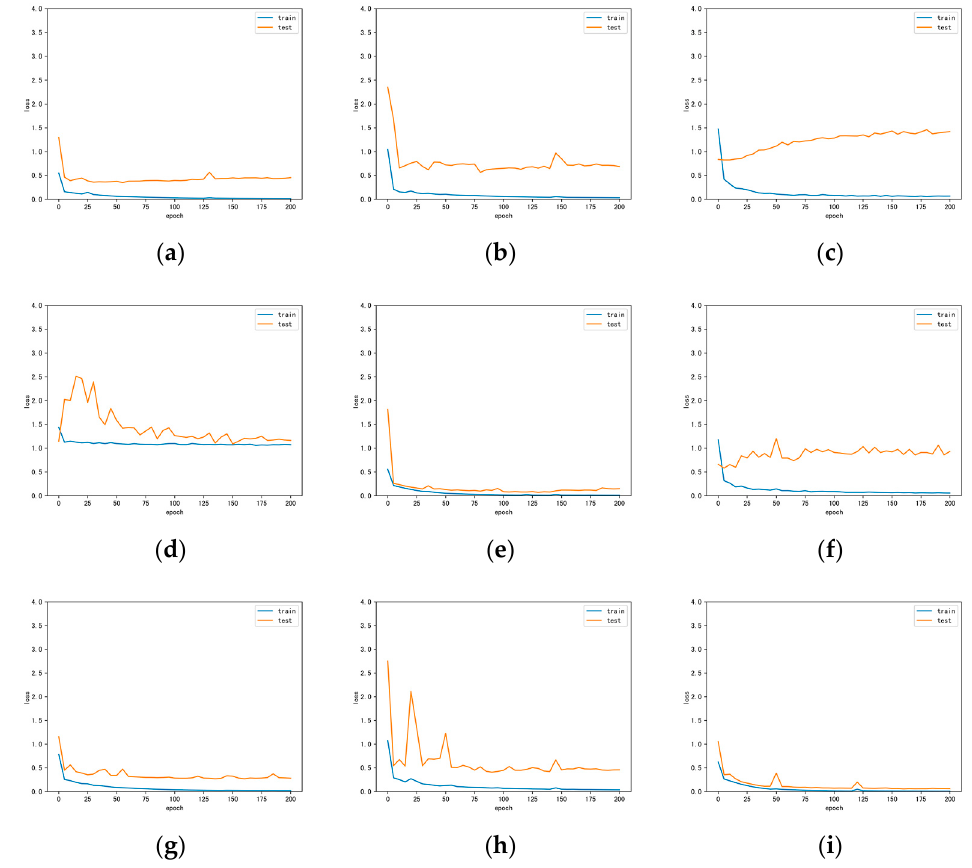
Figure 7. Loss curves obtained by different methods for the Trento dataset. ( a ) CNN-H; ( b )